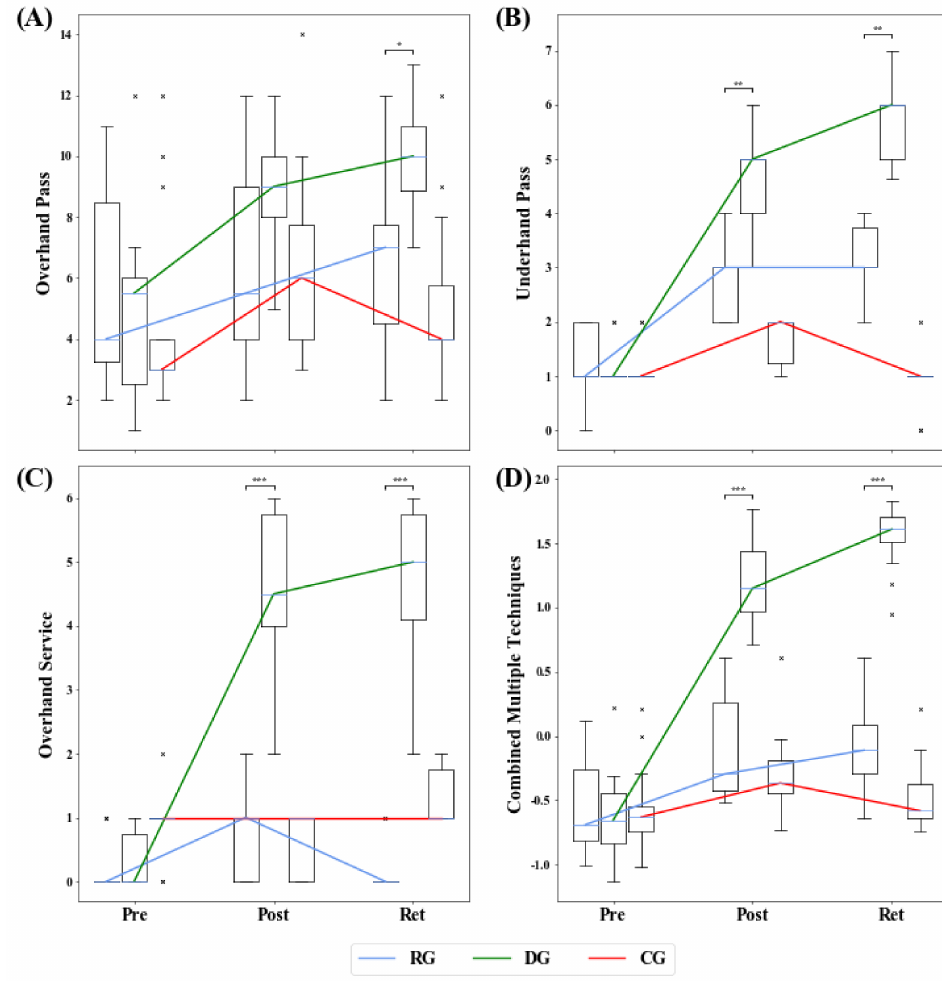
Figure 2. Development of the groups in the test on the respective techniques over the duration of the examination. Values are considered as outliers if they are outside the interval [Q1 − 1.5 * (Q3 − Q1), Q3 + 1.5 * (Q3 − Q1)]. × = outlier (each × stands for one outlier). Brackets show significant differences between RG and DG only. (* p ≤ 0.05; ** p ≤ 0.01; *** p ≤ 0.001). Shown are the boxplots of the overhand pass ( A ), underhand pass ( B ), overhand service ( C ), and combined multiple techniques ( D ). For the clarity of the development of the groups, the median curves are also shown by line plots. RG = repetitive learning group; DG = differential learning group; CG = control group; Pre = pretest; Post = posttest; Ret = retention